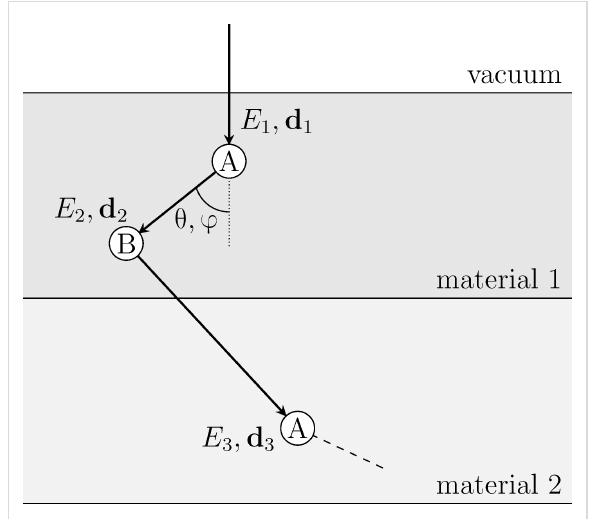
Figure 1: Schematic representation of a random trajectory generated by PENELOPE [7]. The trajectory is determined by the path lengths s that determine the position r n of the next scattering event, by the types of event, and by the energies E n and the directions d n after the event.